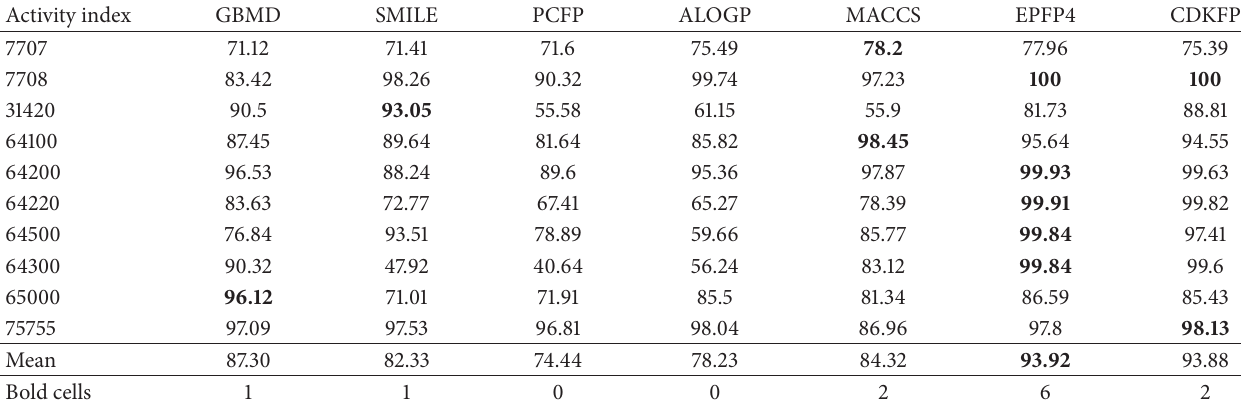
Table 7: Retrieval results of top 5% for data set DS2.